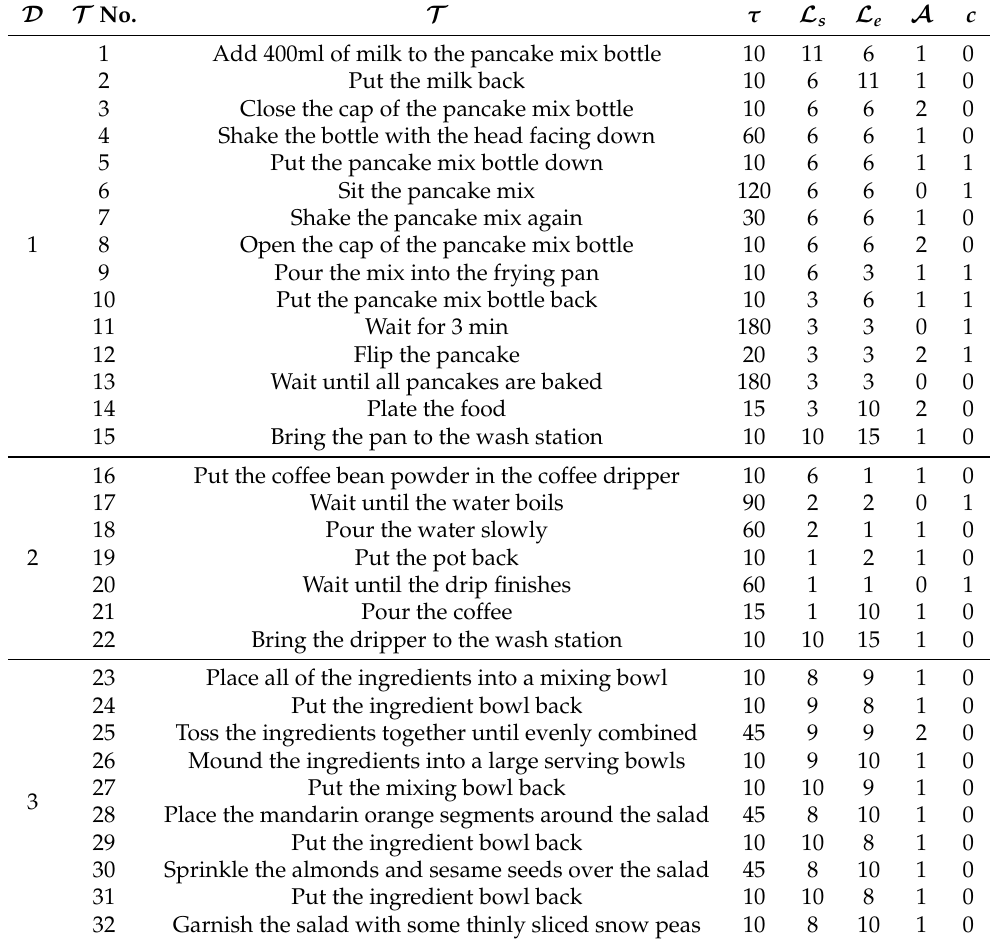
Table 1. An example taskset T